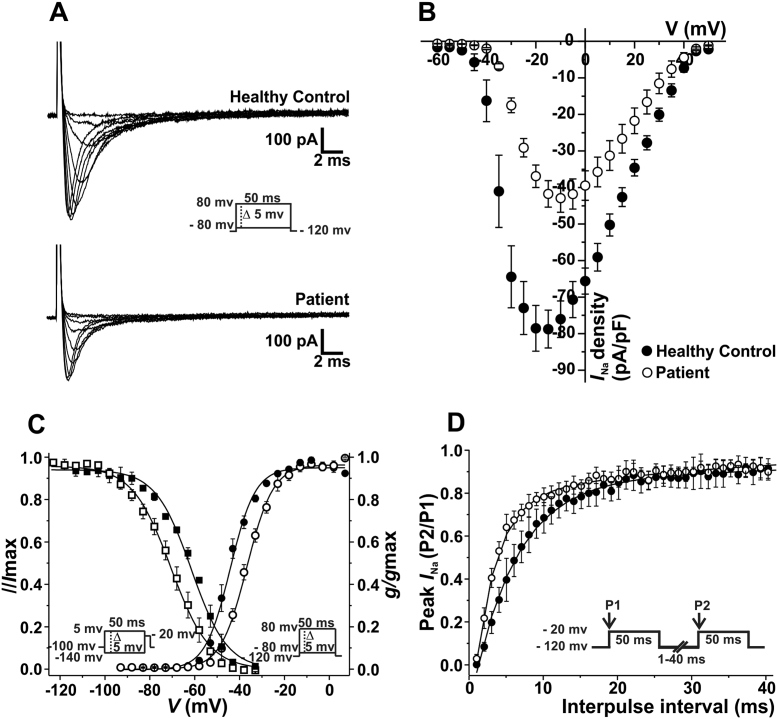
Patient-specific iPS-CM display altered INa properties. Filled symbols are used to depict data for healthy control iPS-CM and open symbols represent values for patient-specific cardiomyocytes. Values are expressed as mean ± SEM. (A) Representative whole cell sodium current traces recorded from control and patient-specific cells. Currents were elicited by depolarizing potentials as shown in the inset. Traces for pulses from − 50 mV to − 15 mV are shown. (B) Current-voltage (I–V) relationship. INa amplitude was normalized to the cell capacitance to obtain current density (INa density) values. Experimental points represent the peak-amplitude of INa density at each given voltage. (C) INa voltage-dependence of activation and steady-state inactivation for control and patient cells. Conductance values for the activation curve were obtained from the peak current values taken from the I–V relationship. Symbols represent experimental data plotted against the given depolarizing voltage values. Steady-state inactivation protocol is shown in the inset on the left. Symbols represent experimental data plotted against preconditioning pulse values. Solid lines represent the Boltzmann fit of the experimental points. (D) Recovery from inactivation properties were studied by applying the double pulse protocol shown in the inset. A 50 ms depolarizing pulse to − 20 mV (P1) was followed by a hyperpolarizing pulse to − 120 mV of increasing duration (1–40 ms), that preceded a test pulse to − 20 mV (P2). The P2/P1 ratio values plotted against the recovery interval times were fitted to bi-exponential functions (solid lines).